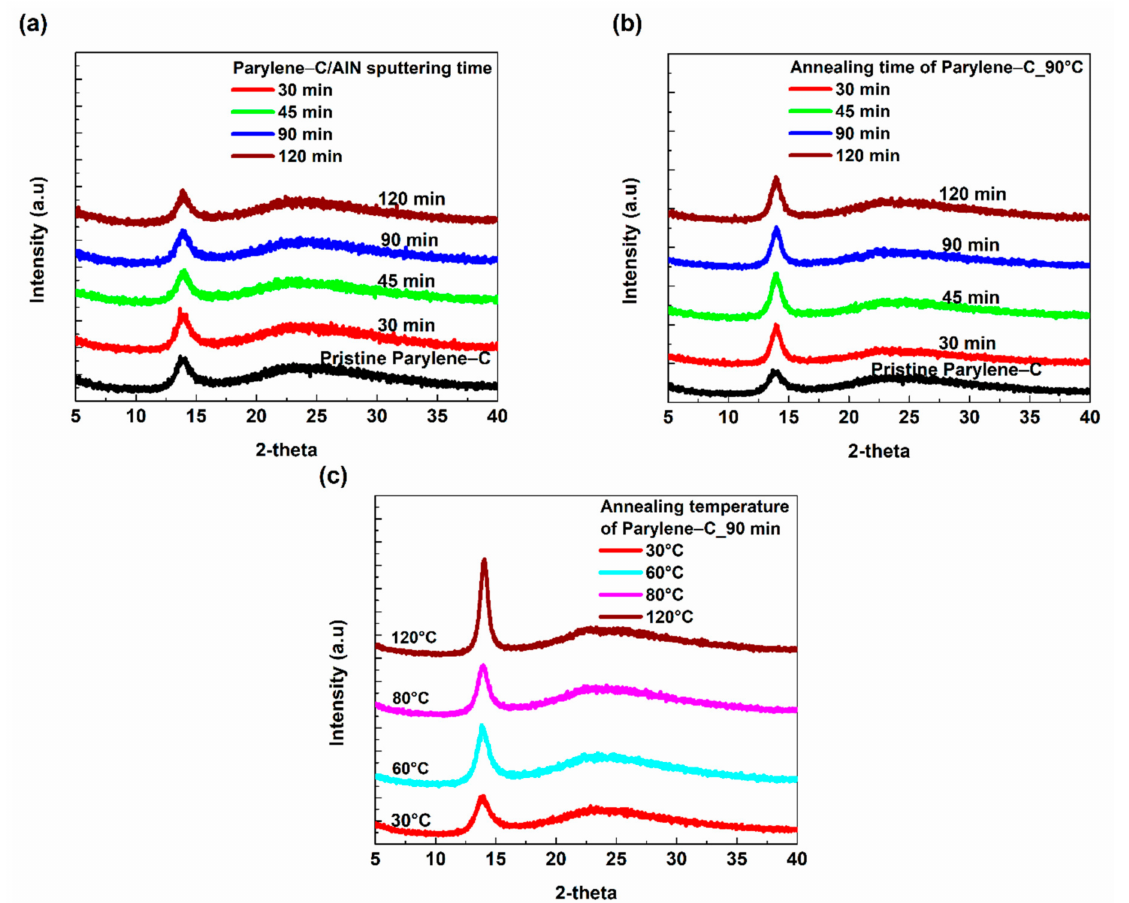
Figure 5. XRD patterns. ( a ) Pristine parylene-C and parylene-C/AlN samples. ( b ) 90 ◦ C annealed parylene-C from 30–120 min. ( c ) 30, 60, 80 and 120 ◦ C annealed parylene-C for 90